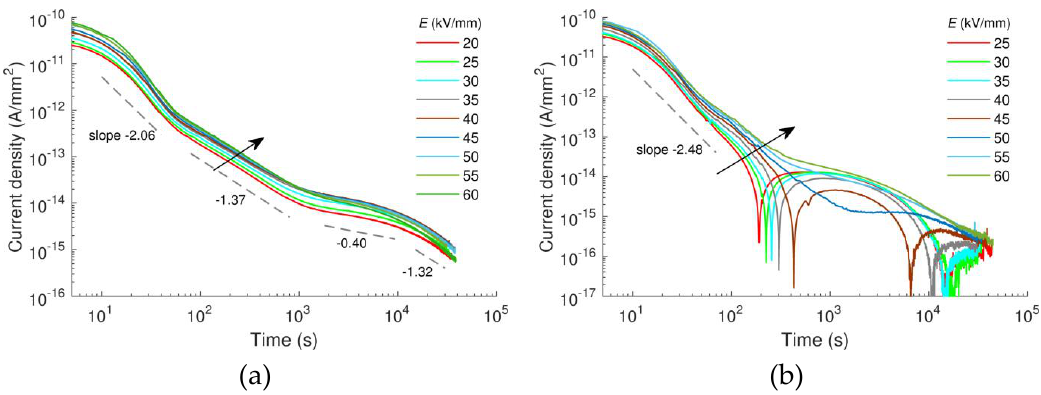
Figure 4. Time dependencies of discharge current densities measured after charging at the indicated electric field levels (in kV/mm); (a) LDPE, 60 °C and (b) LDPE/Al 2 O 3 3 wt% nanocomposite, 80 °C. Arrows show the variation of the currents with the increasing field strength.